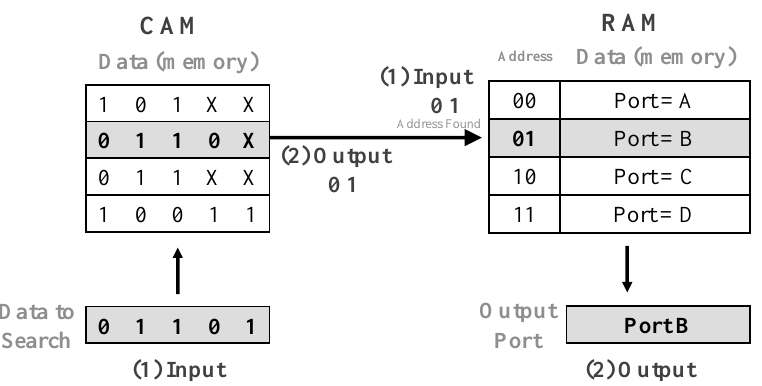
Figure 1. Comparison of content-addressable memory (CAM) and random-access memory (RAM).